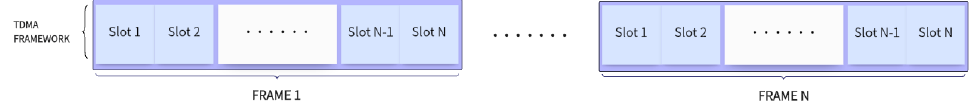
Figure 4. TDMA framework. Time is divided into a sequence of frames, with each frame further scattered into a set of